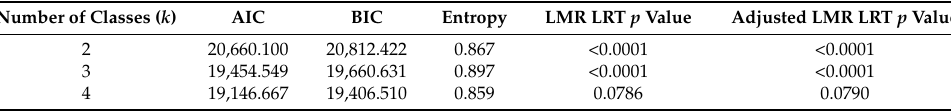
Table 5. Latent profile model fit indices of place value.